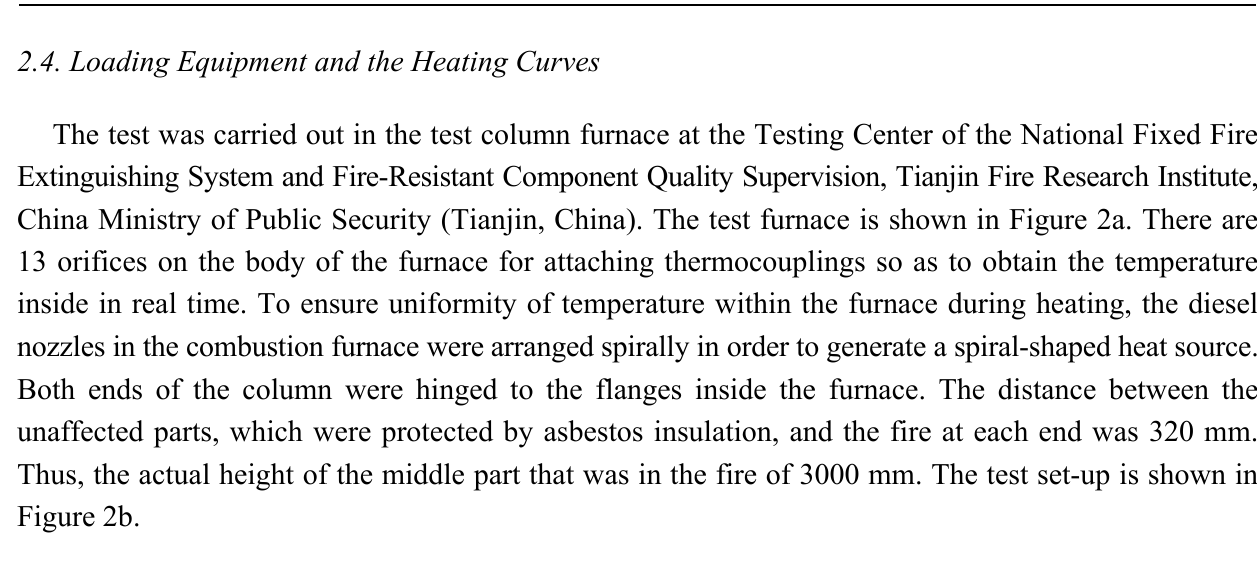
Figure 2. ( a ) Test furnace; and ( b ) test